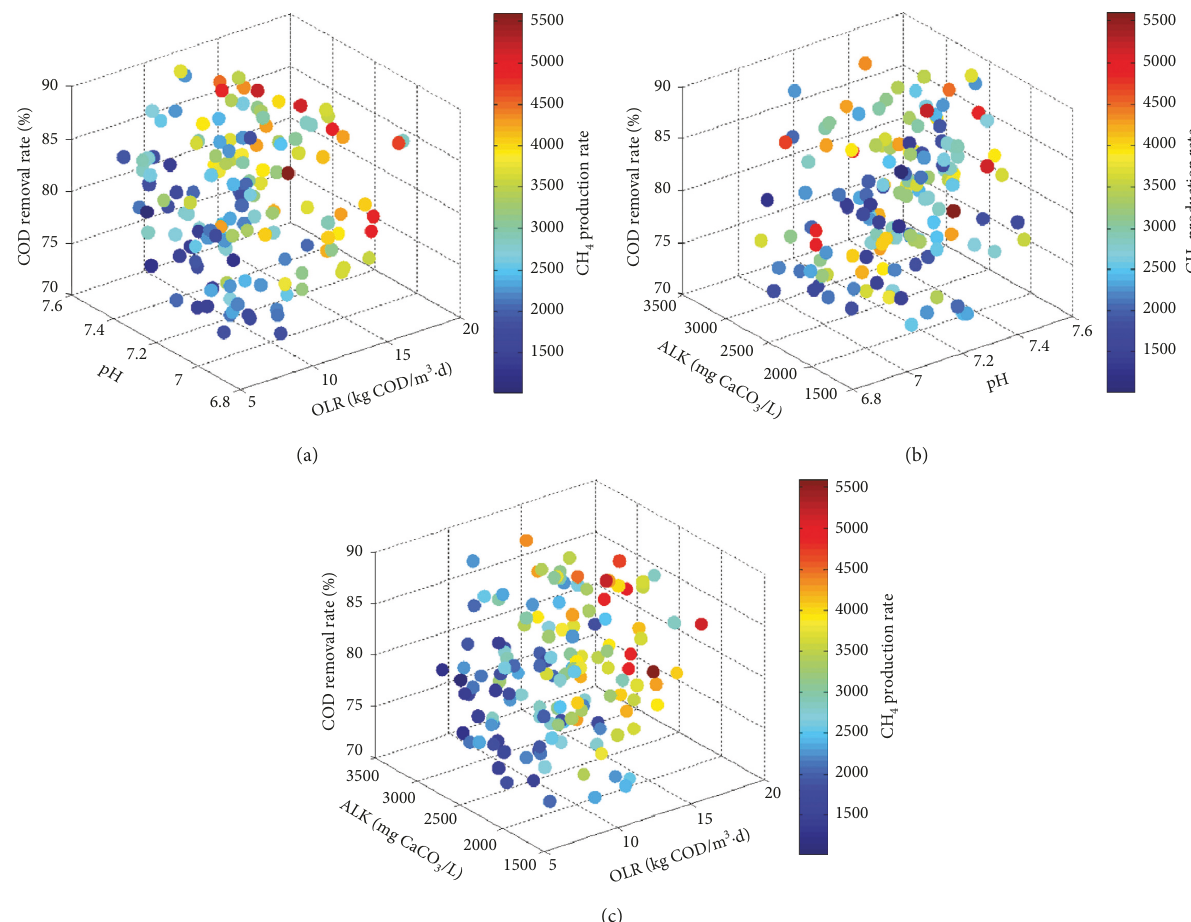
Figure 5: Impact of the parameters (a) pH and OLR, (b) ALK and pH, and (c) ALK and OLR on COD removal and CH